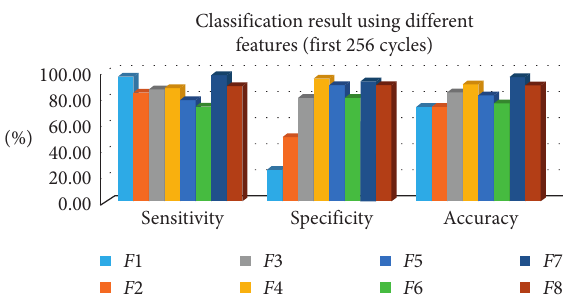
Figure 6: Classification result with data from first 256